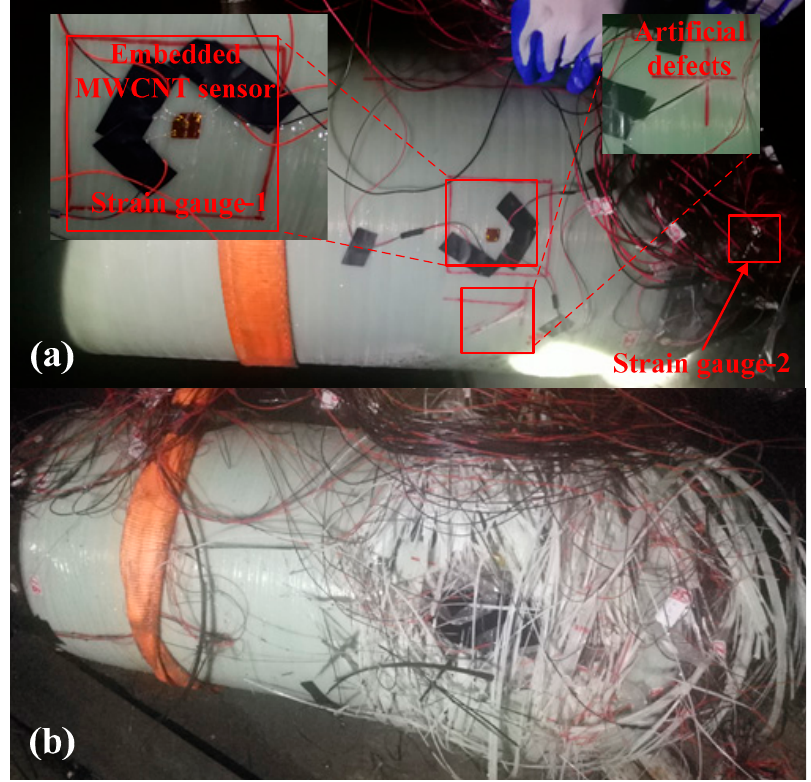
Figure 4. Pressure vessels before and after bursting: (a) before bursting, (b) after bursting.